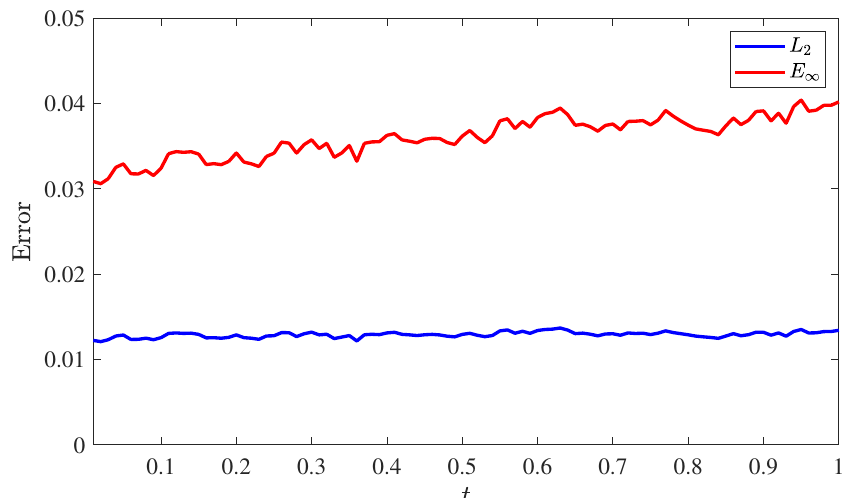
Figure 6. Problem of Example 3: Time versus the relative spatial error L 2 and maximum absolute error E ∞ until the final time step is reached, where ∆ t is fixed to be